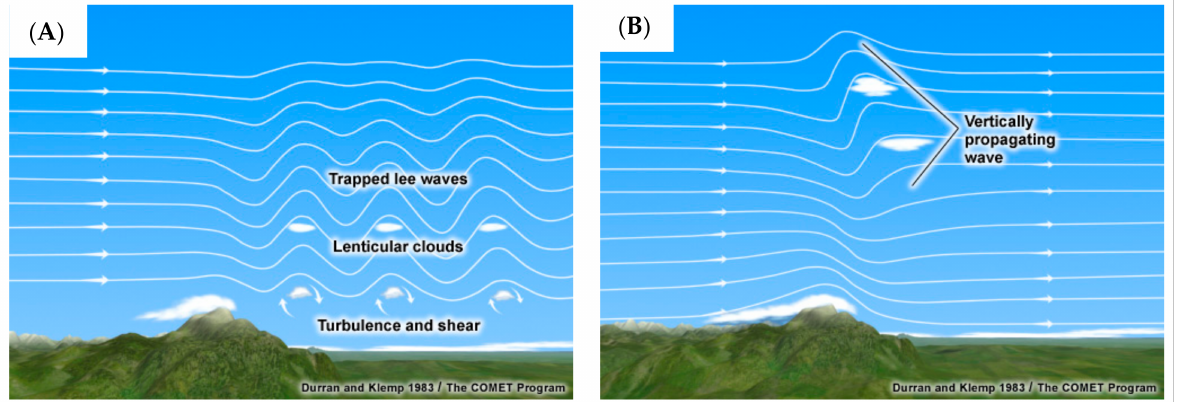
Figure 1. ( A ) Trapped lee waves. ( B ) Vertically propagating lee waves